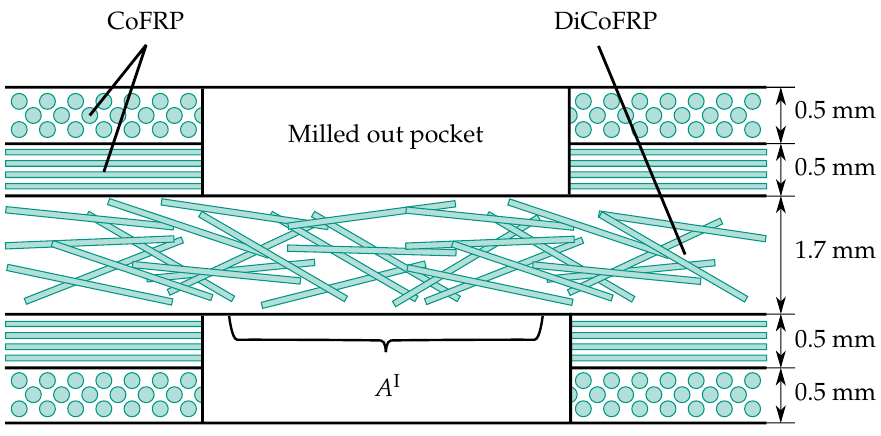
Figure 10. Cross section of continuous fiber reinforced SMC, with milled pockets in the area of interest.